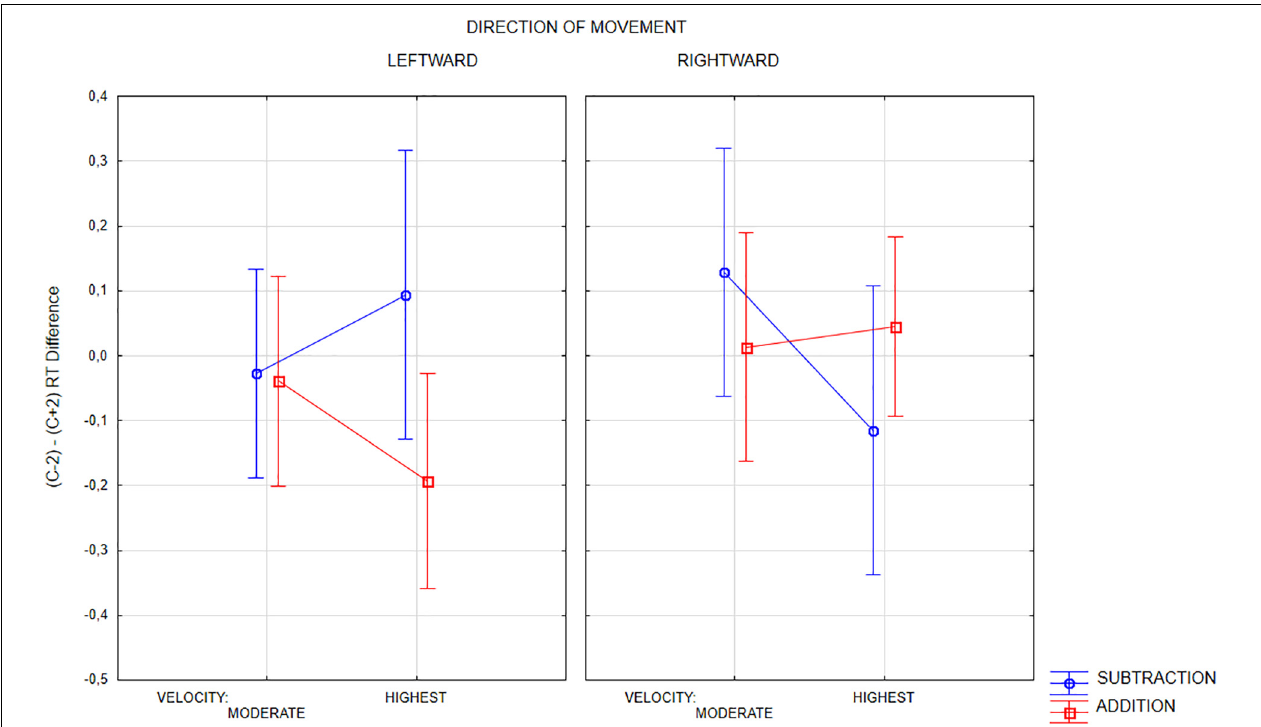
FIGURE 6 | Three-way interaction of OPERATION , VELOCITY (speed), and MOVEMENT DIRECTION with the differential index of RT (c–2) - (c + 2). Only short-lasting trials included. Positive values of the differential index mean that in a given condition, the response to a too low outcome option (c–2) took a longer time than the response to an too high outcome option (c +